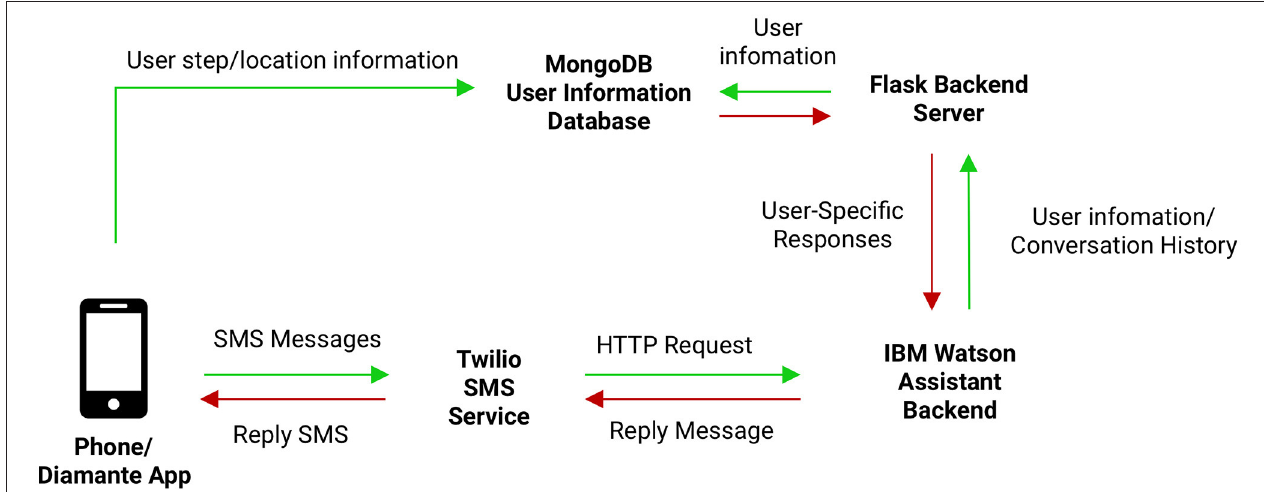
FIGURE 1 | We used a front end SMS interface for communication, through the Twilio communication service, and a backend conversational agent using a cloud-based tool, IBM Watson Assistant, for developing and managing conversational flows. We leveraged a custom server for collecting record data and managing scheduled tasks, through a backend REST API implemented in Python Flask, with a MongoDB